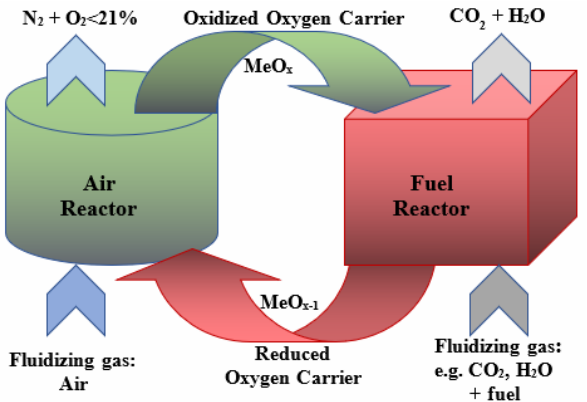
Figure 3. The scheme of the oxidation and reduction in the oxygen carrier in the reactors.